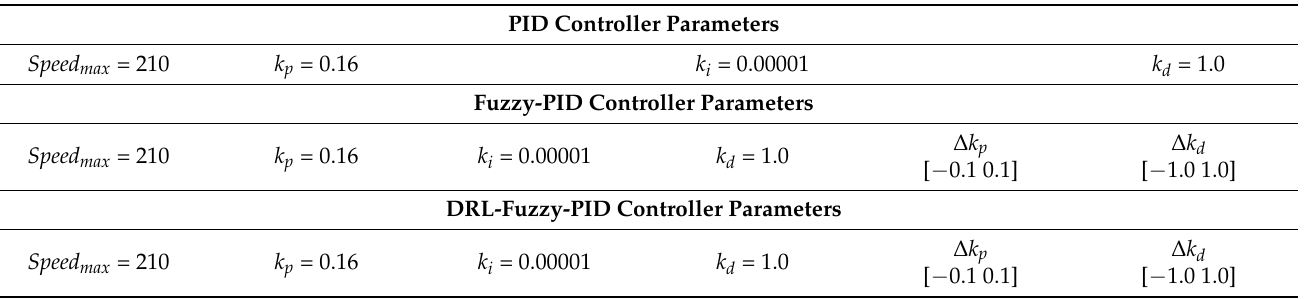
Table 4. Parameter design of conventional PID, Fuzzy-PID, and DRL-Fuzzy-PID control for site tracking. PID Controller